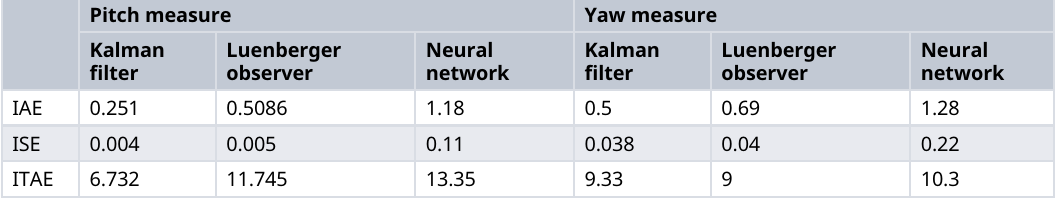
Table 1. Performance errors of the three techniques: Kalman filter, Luenberger observer, and neural network. Integral Absolute Error (IAE), Integral Square Error (ISE), Integral Time Absolute Error